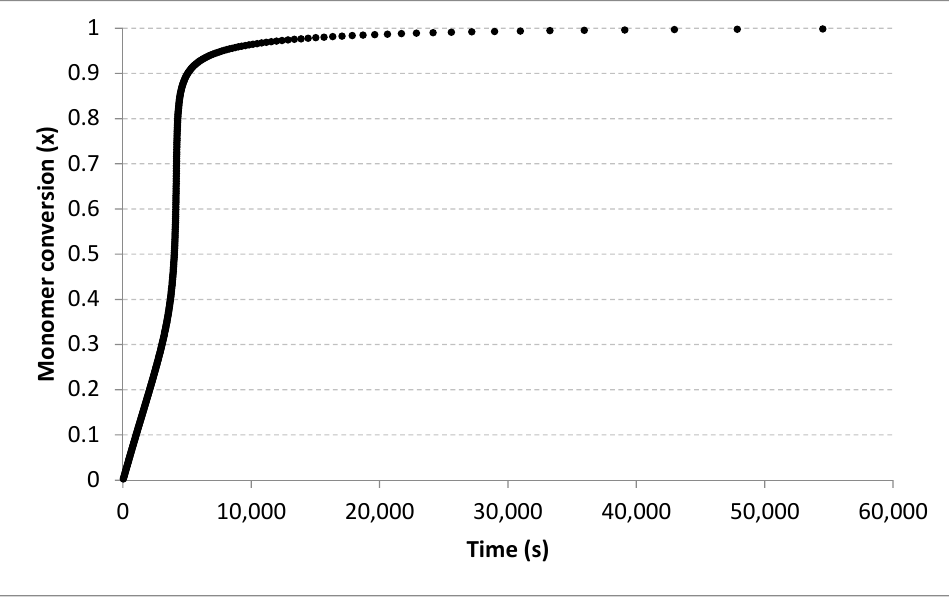
Figure 2. Adaptively sampled points (414) for the numerical average molecular weight ( M n ). 6. Results and Discussion In a previous study [22] we compared the results of several well-known algorithms from the Weka collection [2] with those of LMNNR for the three formulated problems, i.e., the conversion, average numerical and gravimetric molecular weights. The algo- rithms considered from Weka were: kNN, random forest, REPTree, M5 rules, additive regression, ε -SVR and ν -SVR, each with different values for their parameters. The data were split into 2/3 for training and 1/3 for testing. Table 1 presents a concise comparison between the best classical algorithm (random forest) and LMNNR (with one prototype, five optimization neighbors and five regression neighbors) in terms of the coefficient of determination ( R 2 ) obtained for both the training and testing sets.